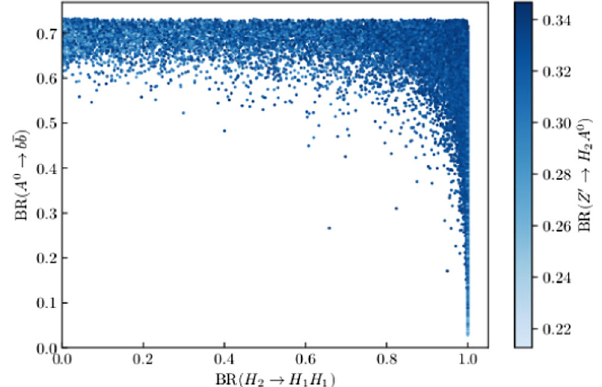
Fig. 2 Branching ratio for Z (cid:2) → H + H − versus Z (cid:2) → Zh (top) and Z (cid:2) → t ¯ t (bottom) resulting from the parameter space scan in scenario 1. The vertical lines correspond to the experimental upper bounds. The colour grading is related to the m H ± value as shown on the right